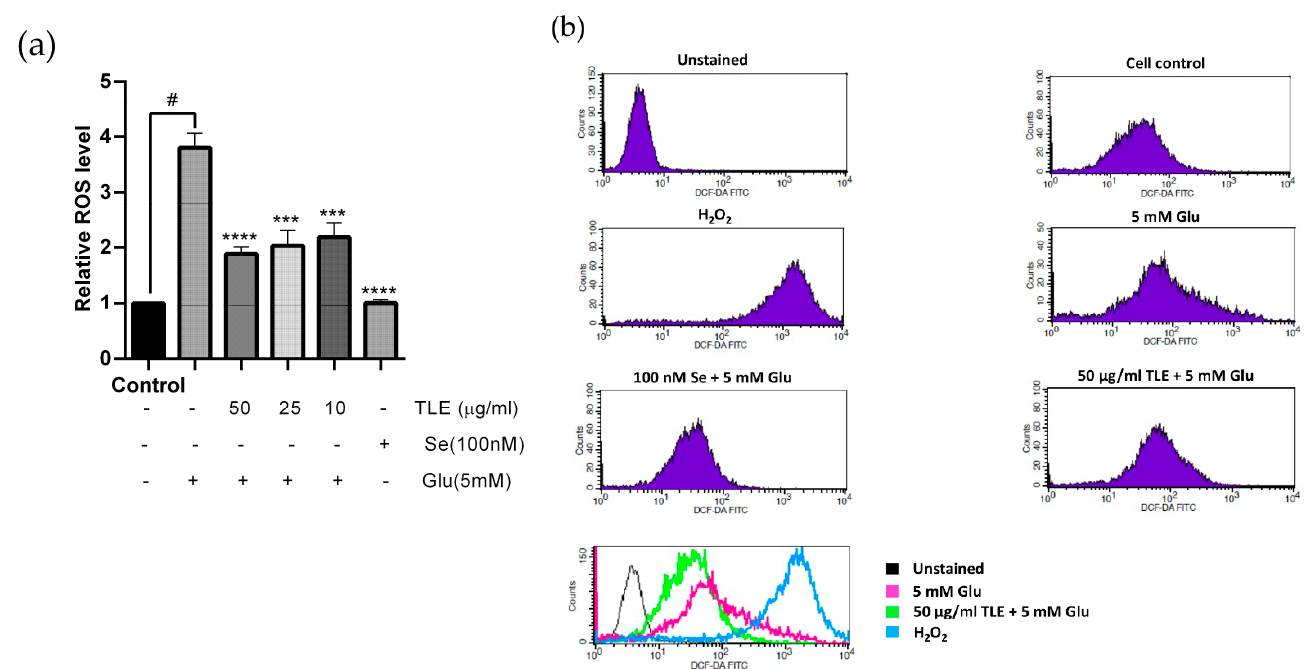
Figure 2. TLE inhibits glutamate-induced intracellular ROS production. Flow cytometry was used to detect the fluorescence intensity of DCF. HT-22 cells (passage 15,16,18,19) were pre-treated with TLE at different concentrations (10–50 µ g/mL) or selenium (100 nM) for 24 h and then exposed to 5 mM glutamate for 18 h. ( a ) The bar graph of each treatment shows the relative ROS level in HT-22 cells. ( b ) The flow cytometry histogram and the overlay of the histogram of each treatment; unstained (black), TLE treatment with glutamate (green), 5 mM glutamate treatment (pink) and 250 mM H 2 O 2 treatment (blue). The data were collected from at least three independent experiments and the results are shown as mean ± SEM. *** p value < 0.005, **** p value < 0.001 compared with glutamate treatment group, # p value < 0.001 compared with untreated control.